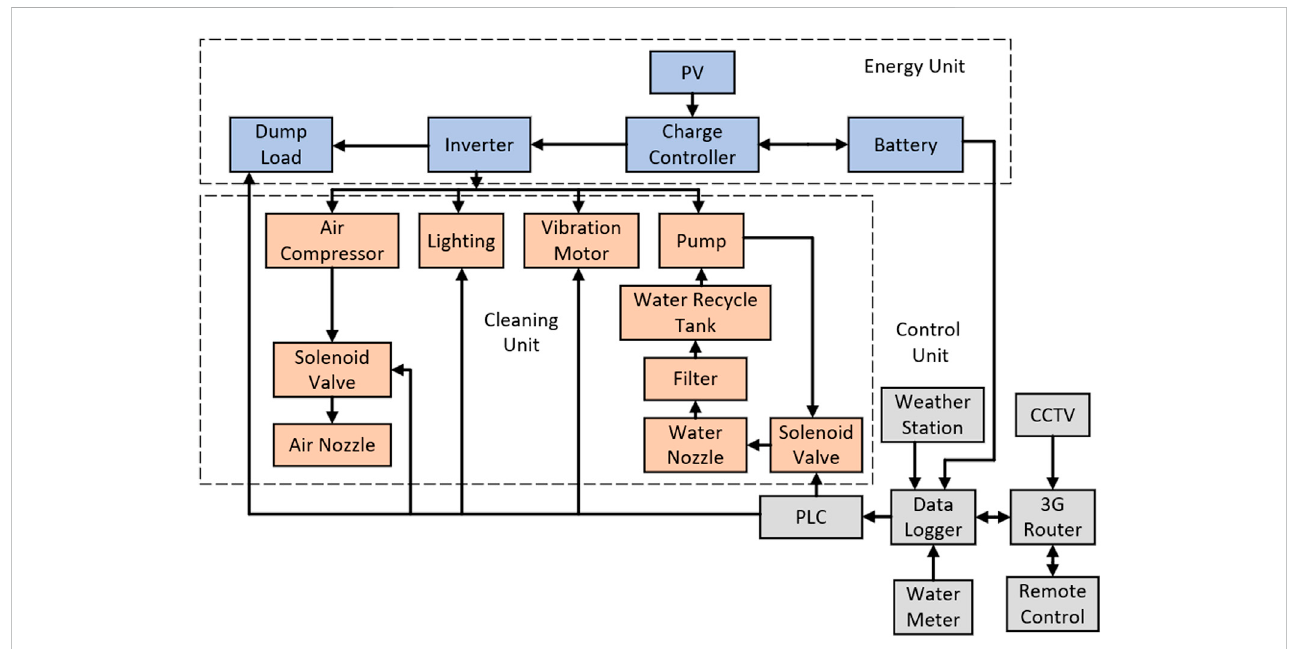
FIGURE 5 A schematic representation of an automated dust cleaning method for PV modules. Redrawn based on ref. (Alghamdi et al.,